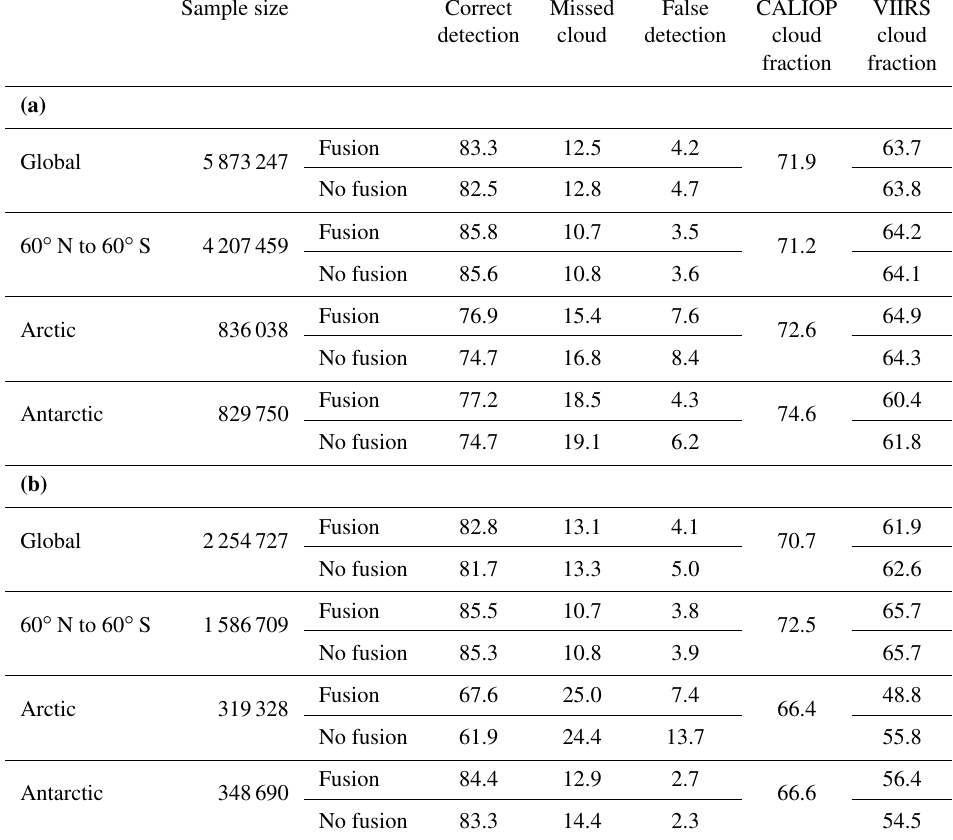
Table 2. Validation of (a) S-NPP and (b) NOAA-20 cloud mask detection against CALIPSO/CALIOP using data collocated globally. Data with cloud optical thickness less than 0.03 are filtered out.